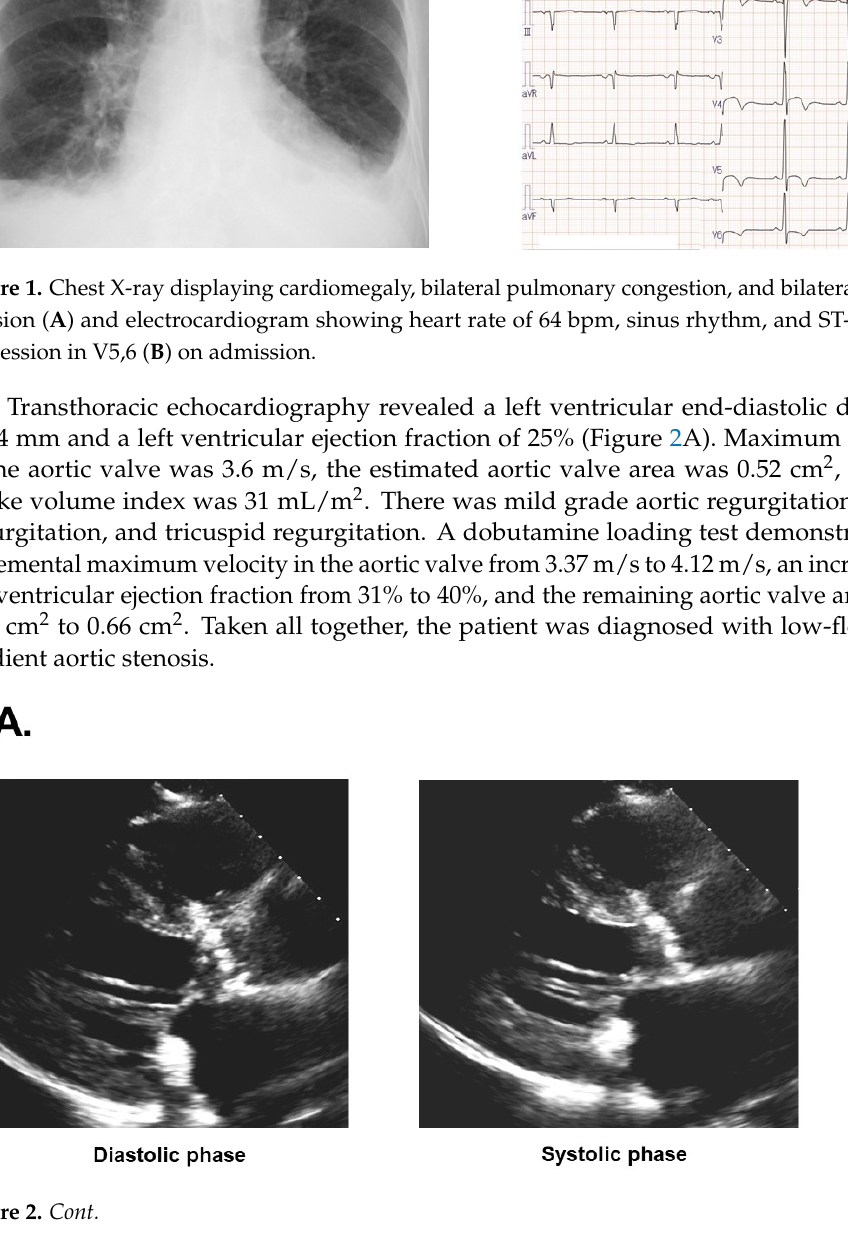
Figure 2. Transthoracic echocardiography (long ‐ axis view) at diastolic/systolic phase on admission expressing left ventricular ejection fraction of 25% ( A ) and those following 3 ‐ month medical therapy showing left ventricular ejection fraction of 36% ( B ). Abdominal computed tomography showed stents in the bilateral common iliac ar ‐ teries. However, in ‐ stent lumens were very small: 1.2 mm in the right artery and 2.5 mm in the left artery (Figure 3A,B). The EURO II score was 6.1% and the STS score was 8.0%. The heart ‐ valve team discussed therapeutic strategy and decided to perform a percutane ‐ ous coronary intervention and TAVR.